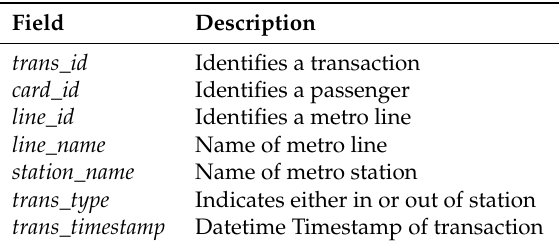
Table 2. List of AFC data